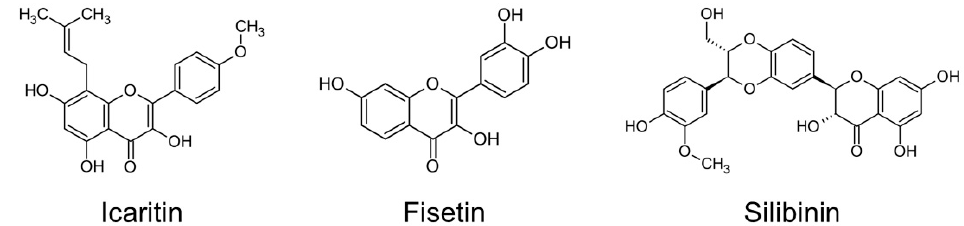
Figure 1. Chemical structure of flavonoids used in this study. Table 1. Physical and chemical properties of flavonoids used in this study.